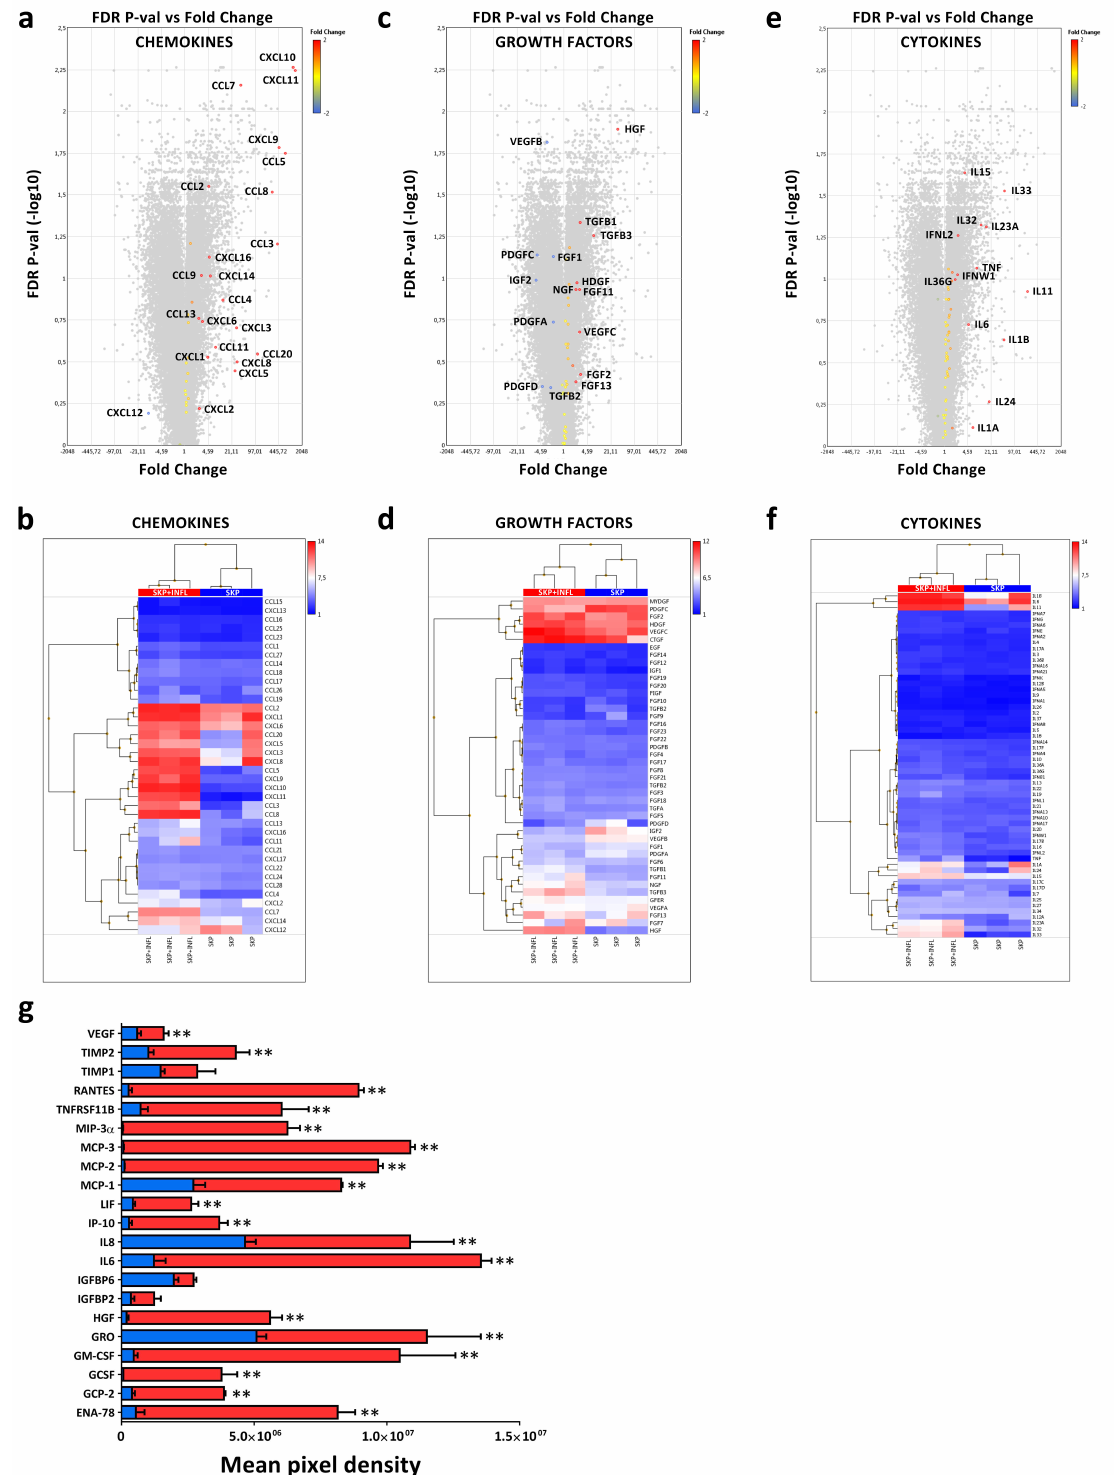
Figure 2. Inflammation alters the secretome of SKP and leads to drastically increased HGF secretion levels. Volcano plots and heatmaps representing ( a , b ) chemokine, ( c , d ) growth factor and ( e , f ) cytokine mRNA expression changes in SKP + INFL versus SKP. ( g ) Superimposed graph showing the protein secretion levels in SKP (blue bar) and SKP + INFL (blue + red bar). The values are expressed as mean ± SEM and originate from at least 3 di ff erent SKP donors. ** Significantly increased secretion versus SKP ( p -value <